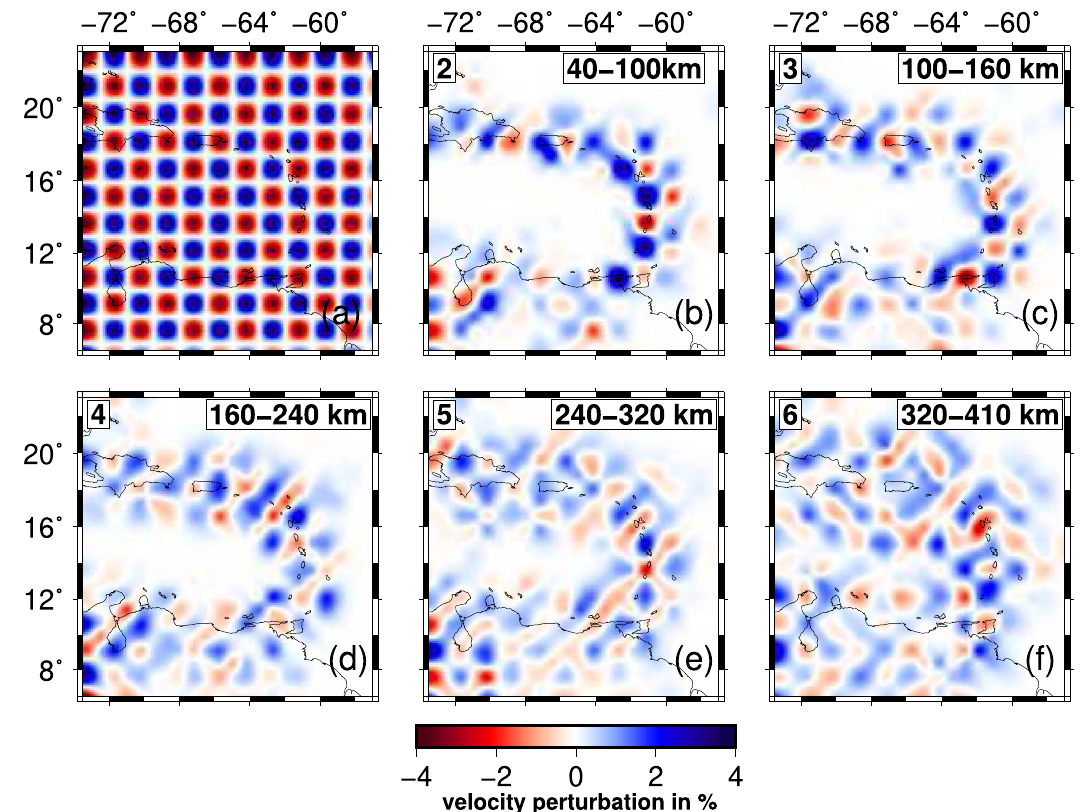
Fig. 2 Resolution for model VoiLA-P19, illustrated by checkerboard tests. a The input models for the synthetic tests consist of alternating positive and negative velocity perturbations of 10%, either in the odd- or even-numbered layers of the local grid. The horizontal distance between positive and negative anomalies is 1.5°, and their signs are reversed in every perturbed layer. Examples are shown of recovery in ( b ) layer 2 between 40 and 100 km depth, ( d ) layer 4 between 160 and 240 km depth, and ( f ) layer 6 between 320 and 410 km depth for a test where input anomalies are placed only in even-numbered layers. Recoveries in ( c ) layer 3 (100 – 160 km depth) and ( e ) layer 5 (240 – 320 km depth) are illustrated for input anomalies in odd-numbered layers. More tests are shown in “ Methods ” and Supplementary Figs. 5 –